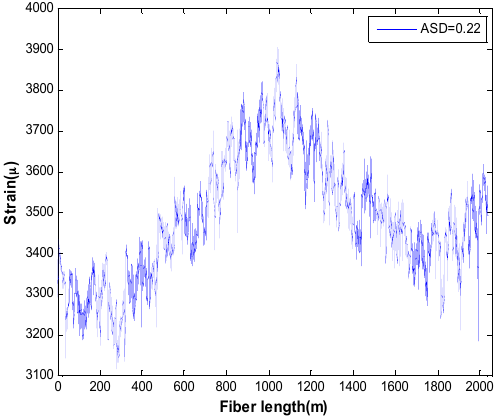
Figure 9. Strain distribution of the QAD fiber coil.